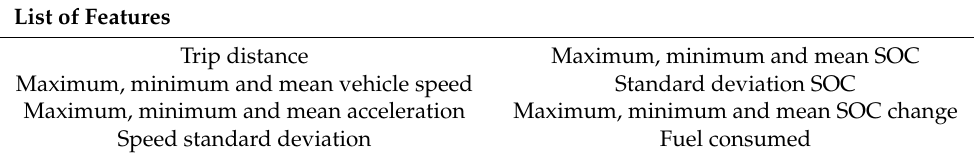
Table 1. A List of 16 selected features for EF estimation. List of